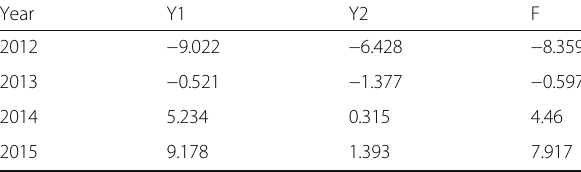
Table 6 Scores of PCA factors of green mine